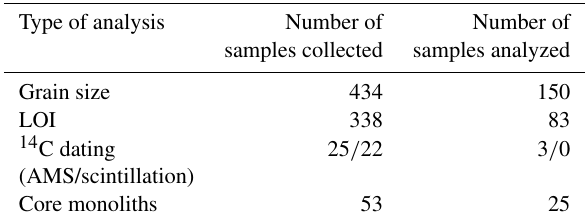
Table 1. Sampling protocol of the 2016–2019 field